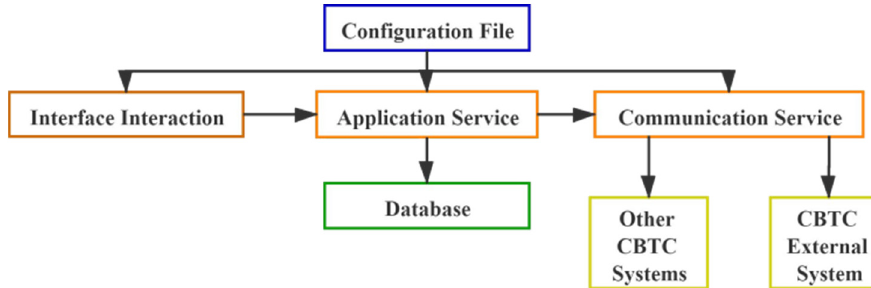
Figure 2. The structure of the ATS system.